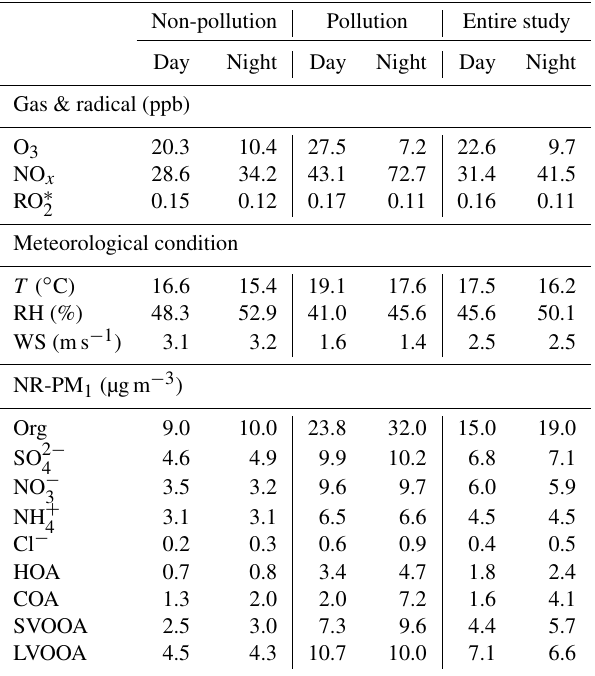
Table 3. Overview of meteorological conditions, trace gases, per- oxy radical, and NR-PM 1 components during day and